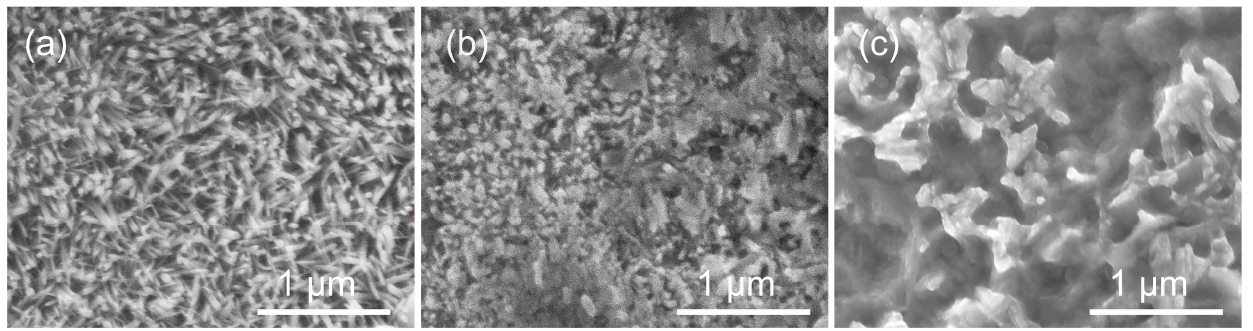
Figure 6. SEM of the cross-section of deposited coating: ( a , b ) are under 100 Hz and 1000 Hz, respec- tively.